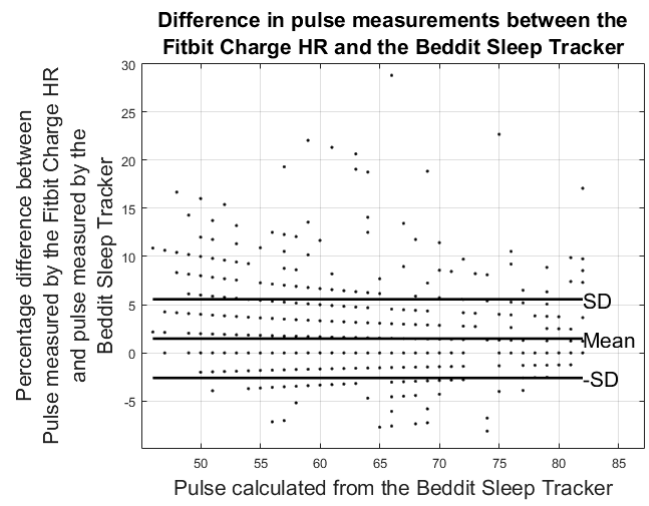
Figure 9. Results from the heart rate study: the plot shows percentage differences in the pulse measured by the Fitbit Charge HR and the Beddit sleep tracker.